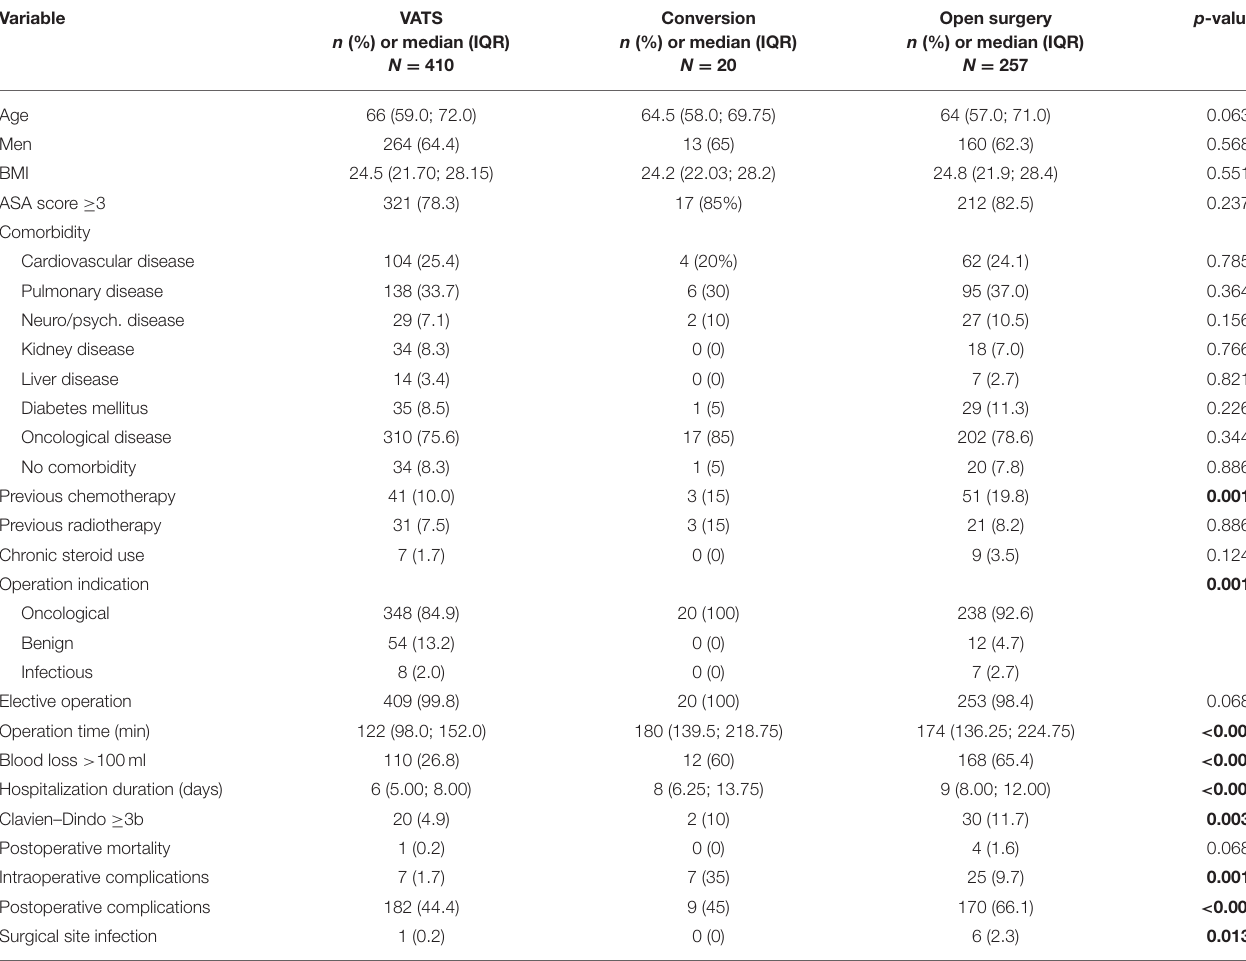
TABLE 5 | Comparison of clinicopathological characteristics of 700 patients undergoing anatomical resection (VATS = 410, Open = 257, Conversion = 20, Missing data = 13) according to access type.